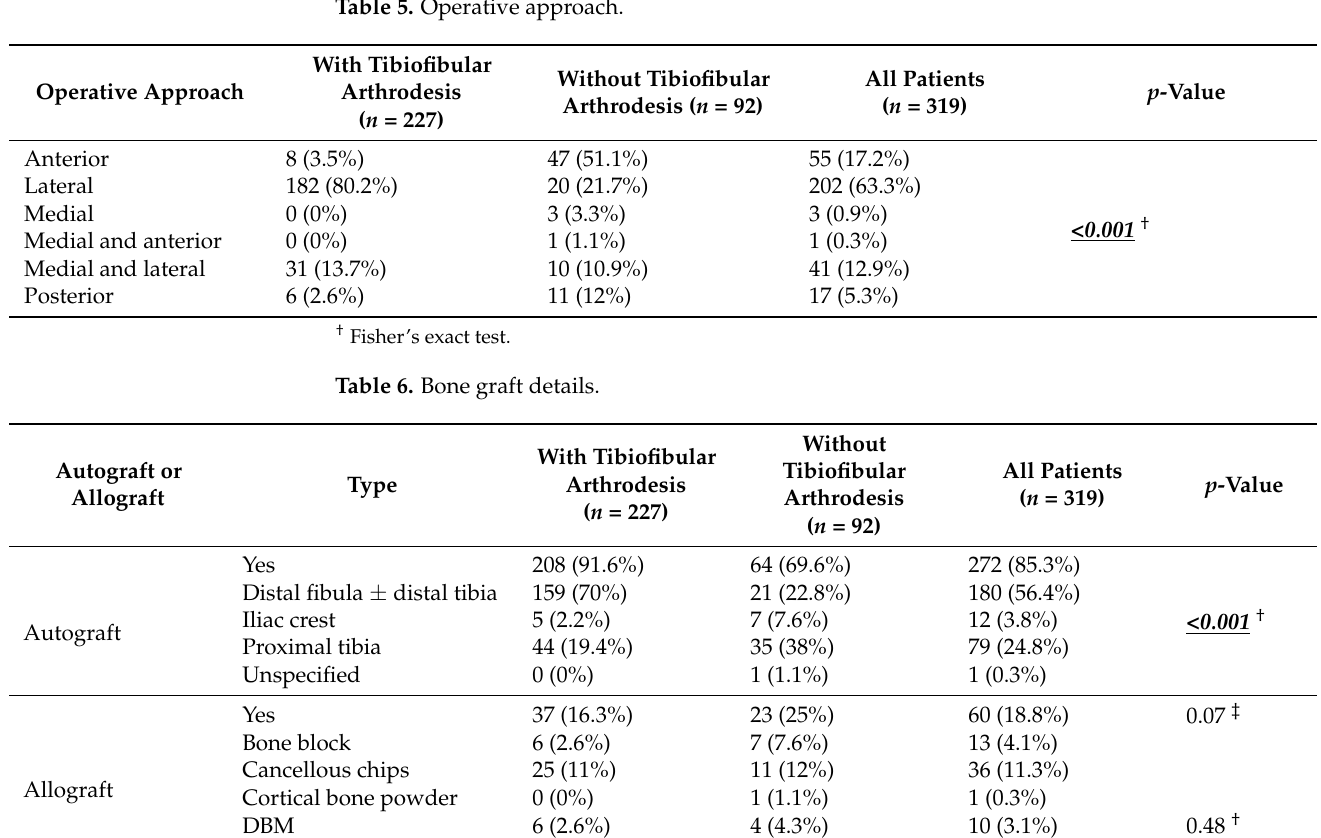
Table 5. Operative approach.